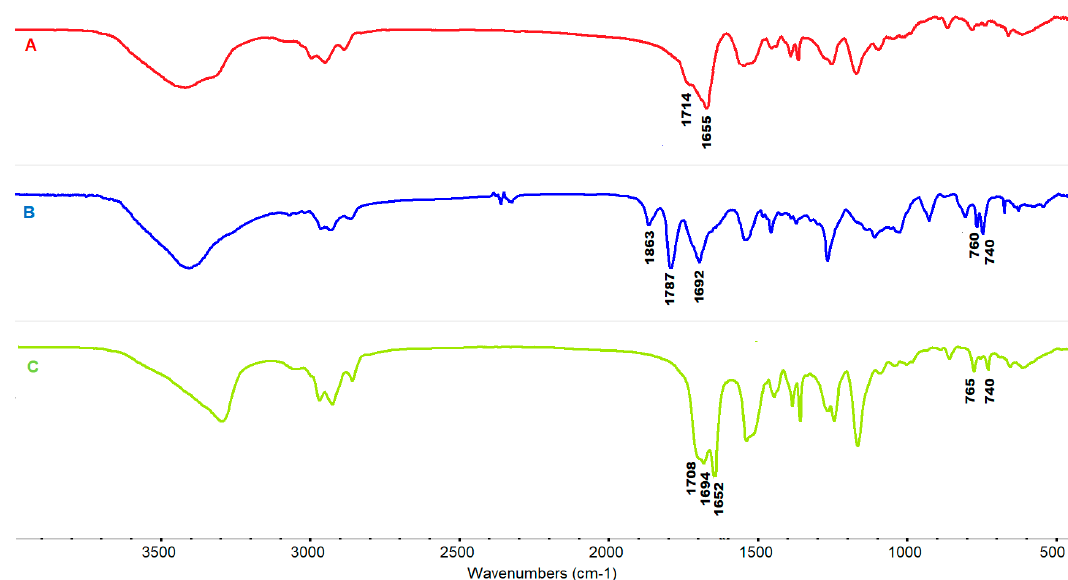
Figure 8. FT-IR spectra: ( A ) after completion of polymerization of the 1st block of PBLL 78 – b –PFLL 10 ; ( B ) of the monomer N ε -Fmoc- l -Lysine NCA; and, ( C ) after completion of polymerization of the 2nd block.